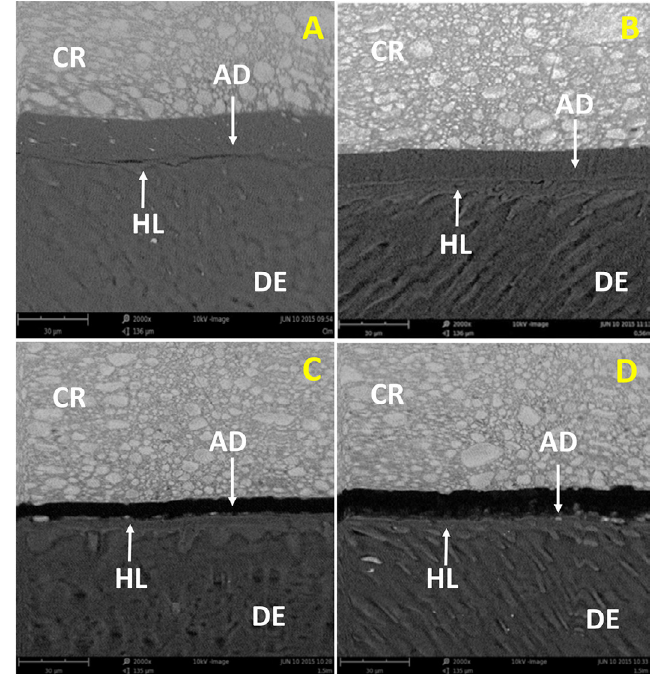
Figure 2- Baseline photomicrographs of the bonding interface between dentin (DE) and composite resin (CR): A) Control group; B) EGCG 0.5 wt%; C) EGCG 1.0 wt%; D) EGCG 1.5 wt%. AD=adhesive; HL=hybrid layer